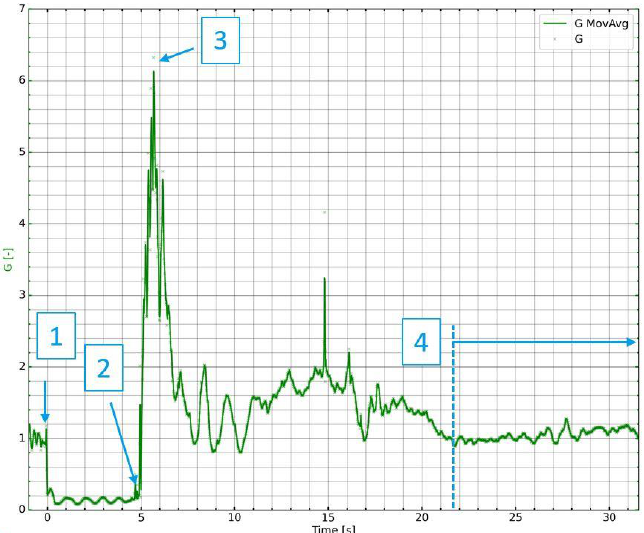
Figure 9. Overload record during reference drop test. 1. release of the system from the airplane; 2. reaching the activation speed – releasing the drogue chute; 3. point of the maximum system overload; and 4. initial point of the steady descent.